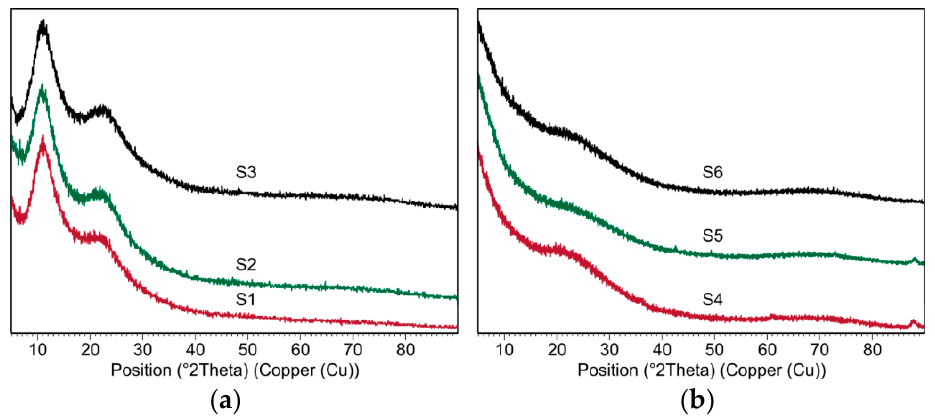
Figure 1. XRD diffraction patterns of ( a ) the xerogels (S1–S3 samples) and ( b ) the silicon oxycarbide materials (S4–S6 samples).